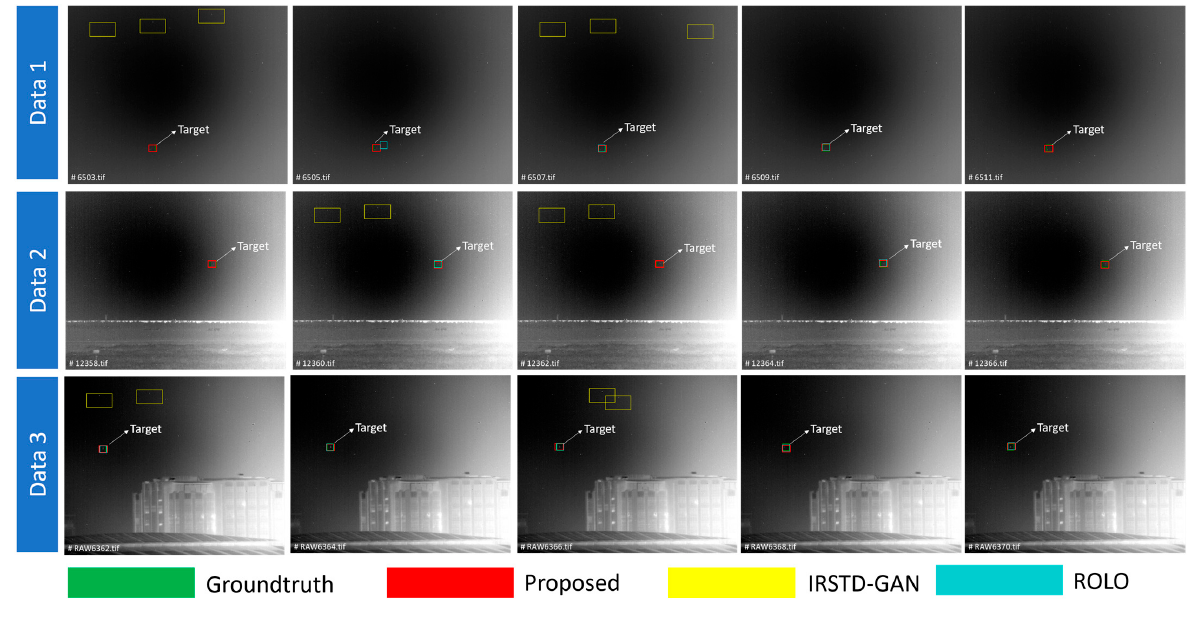
Figure 17. Detection results between our method and CNN-based methods in self-made datasets. The target has been marked by texts, and the other prediction boxes are false alarms. Experimental results show that the proposed method has the highest coincidence with the ground truth. Experimental results show that the detection rate of other deep learning algorithms is obviously lower than the method in this paper.